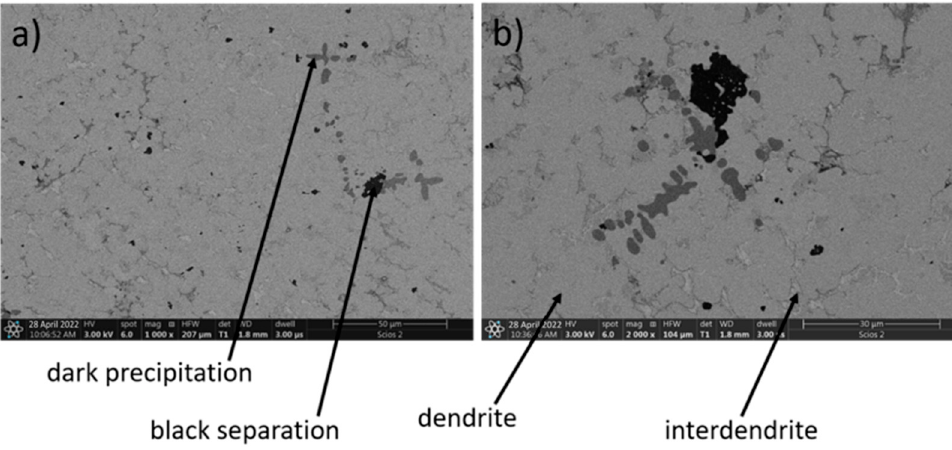
Figure 4. SEM images of Mn 0.5 TiCuAlCr alloy, magnification: ( a ) 1000×, ( b ) 2000×. Table 5. The chemical composition of Mn 0.5 TiCuAlCr alloy.